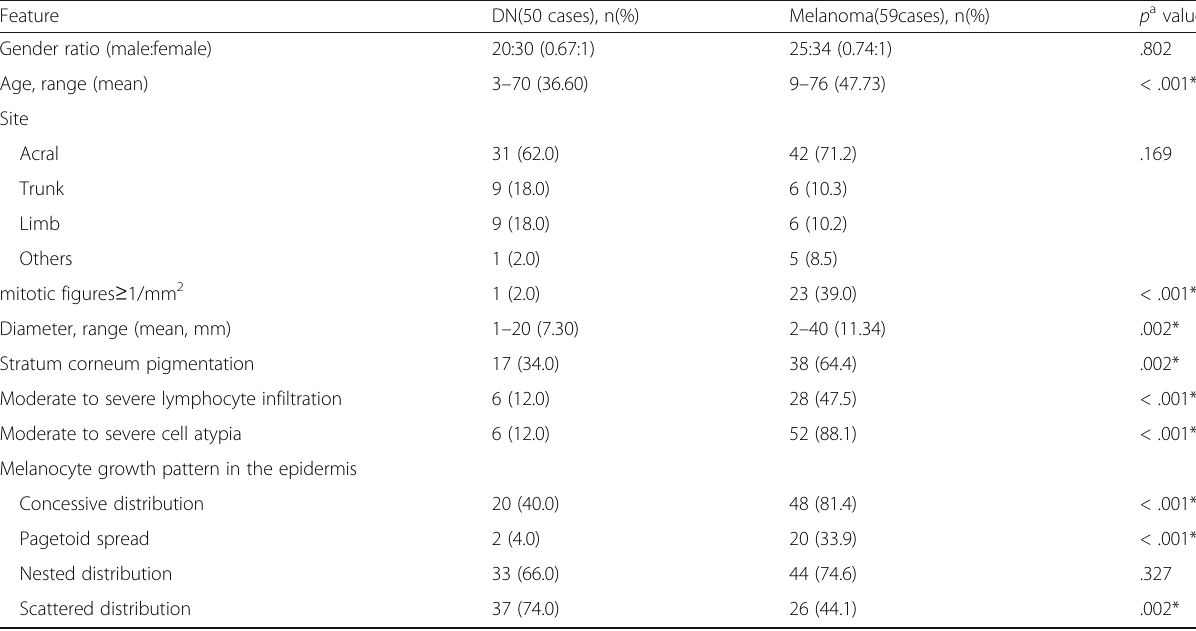
Table 1 Clinicopathological feature of dysplastic nevi and early-stage acral and cutaneous melanomas